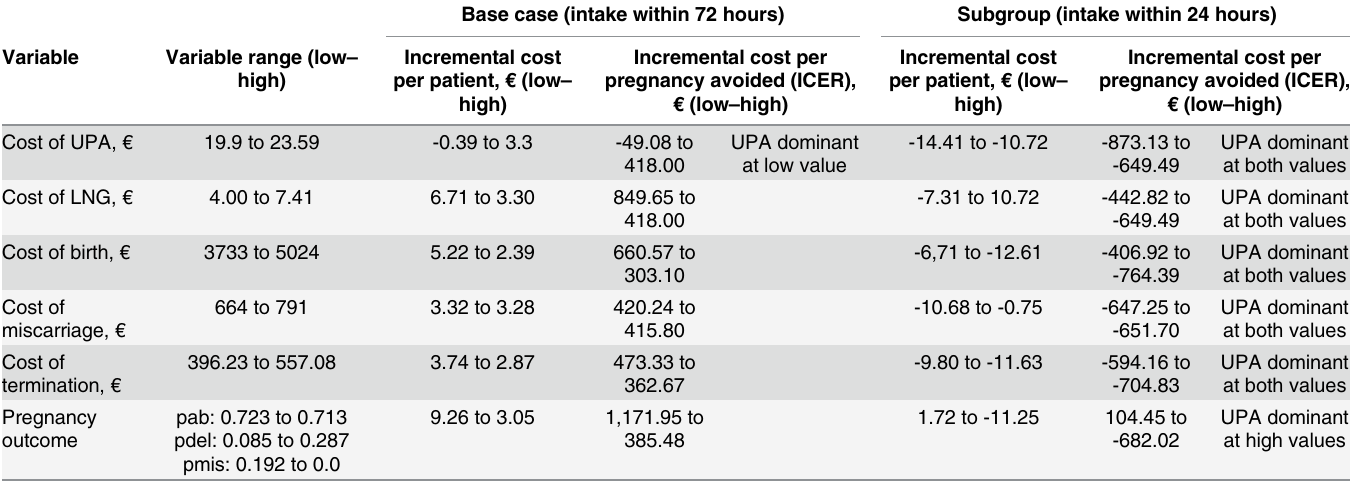
Table 6. Univariate sensitivity analysis of the cost-effectiveness results of levonorgestrel vs ulipristal acetate to variations in main variables of the base case and subgroup models. UPA, ulipristal acetate; LNG, levonorgestrel; UPA dominant, more effective at lower cost; pab, probability of abortion; pdel, probability of delivery; pmis, probability of miscarriage after unprotected